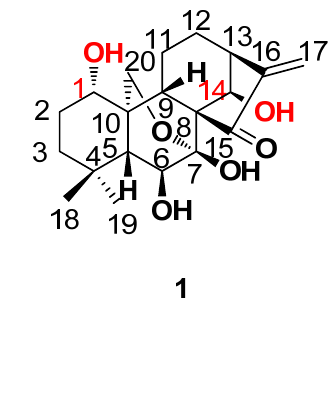
Figure 1. The structure and atom numbering of